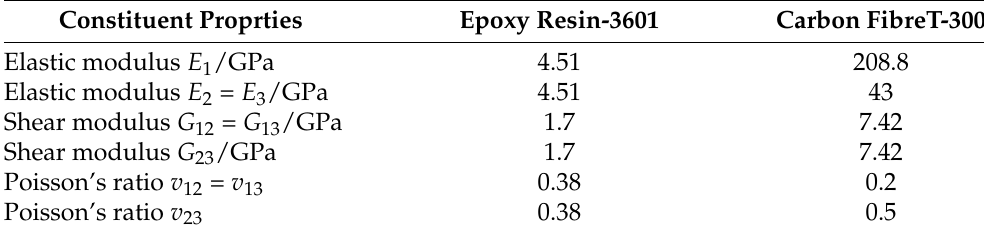
Figure 5. Unit cell model of the yarn. Table 1. Constituent properties of matrix and fiber used in the yarn [35].